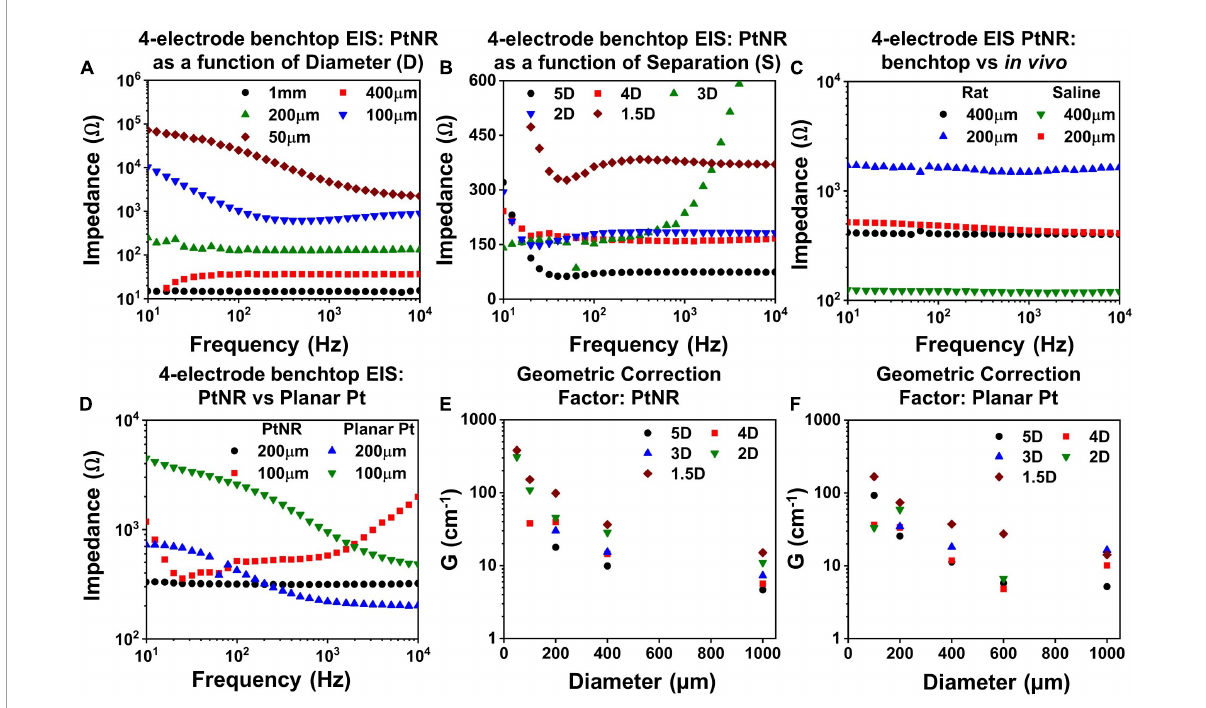
FIGURE5 Measured 4-contact EIS spectra for PtNR contacts as a function of (A) diameter for inter-contact separation of 1.5D in benchtop, (B) inter-contact separation for a contact diameter of 200 µ m and (C) measurement media: in vivo versus benchtop for two diameters with inter-contact separation of 1.5D. (D) Comparison of the 4-contact EIS Spectra for PtNR and planar Pt contacts with diameters of 100 µ m and 200 µ m. Geometric correction factor as a function of diameter for different inter-contact separation for (E) PtNR contacts and for (F) planar Pt